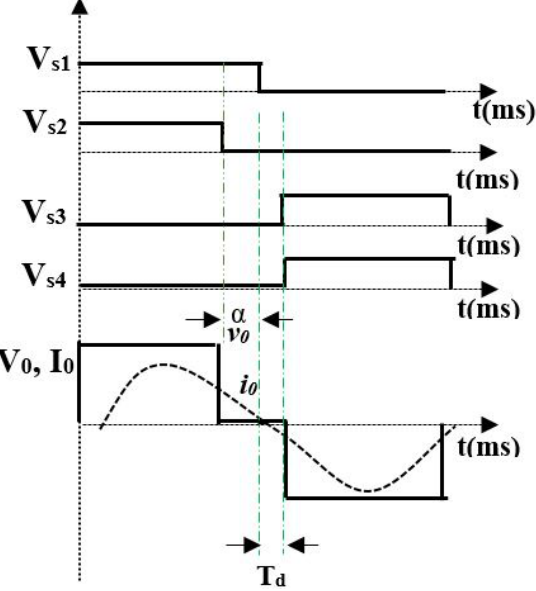
Figure 4. Typical waveforms of asymmetric duty cycle control.